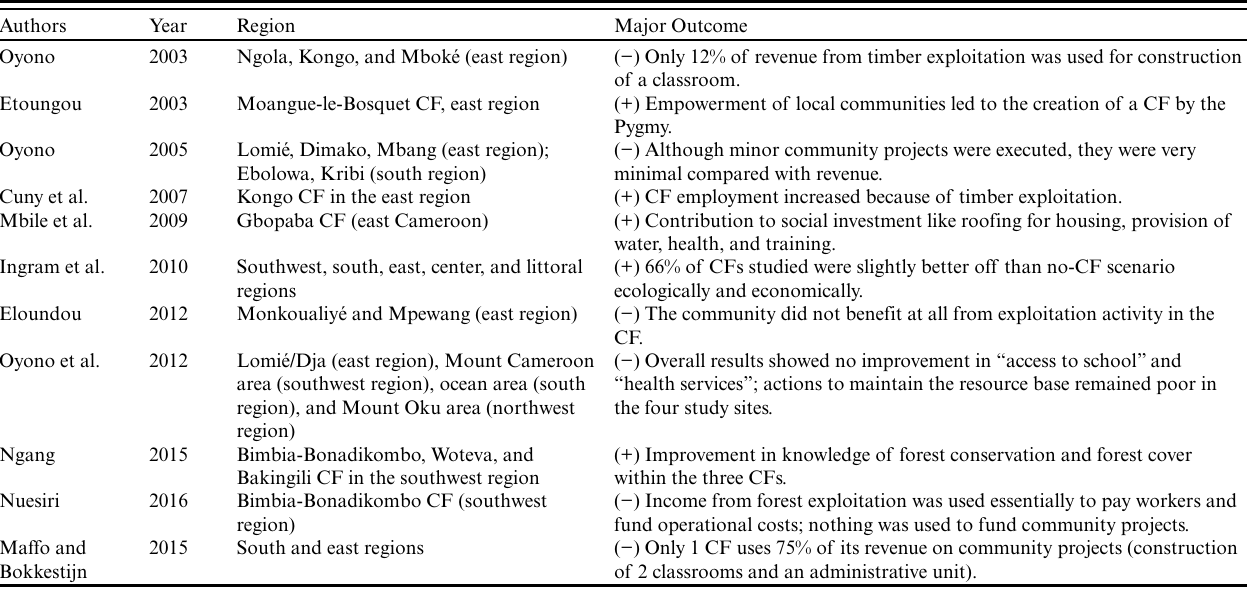
Table 8 . Community forest (CF) performance in Cameroon. Authors Year Region Major Outcome Oyono